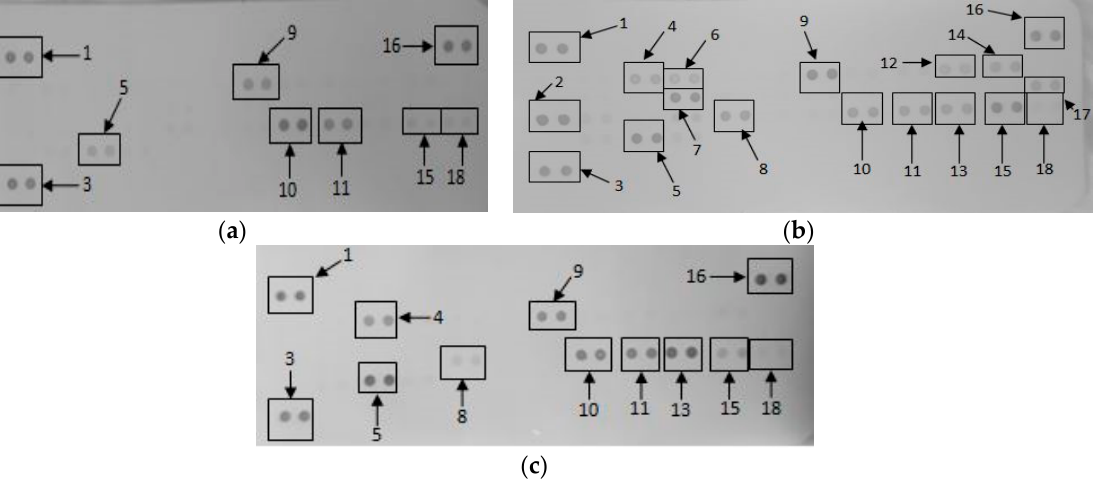
Figure 2. The effect of graphene oxide nanoparticles (GONPs) on RAW 264.7 cells. Cells were incubated with ( a ) media only (negative control); ( b ) media in the presence of LPS and ( c ) 15.6 μ g/mL GONPs in the absence of a mitogen. Supernatants were probed using the proteome profiler array as described in methods. Cytokines/chemokines that were detected were allocated numbers: 1, 3 and 16 are reference spots; 2-IP-10; 4-G-CSF; 5-TNF- α ; 6-GM-CSF; 7-IL-6; 8-JE; 9-sICAM-1; 10-MIP-1 α ; 11-MIP-1 β ; 12-IL-1 β ; 13-MIP-2; 14-IL-1ra; 15-RANTES; 17-IL-27;